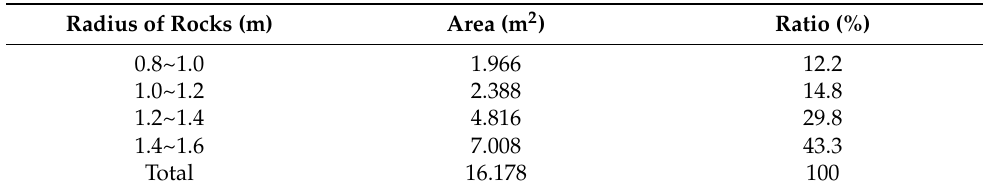
Table 2. Material parameters. Gradation of rock blocks for the soil–rock mixture slopes with different contents of rock blocks.